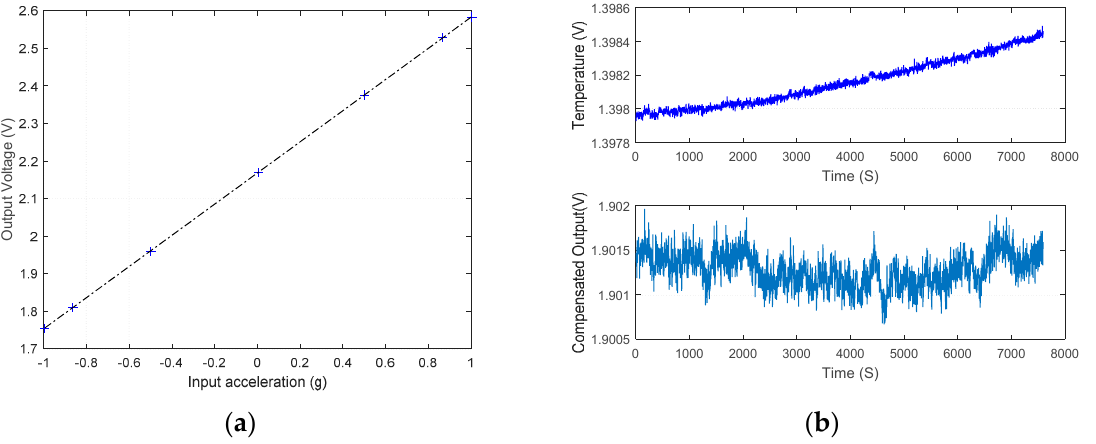
Figure 11. Test results of the accelerometer: ( a ) Relation between output and input acceleration; ( b ) Long-term stability of K0.